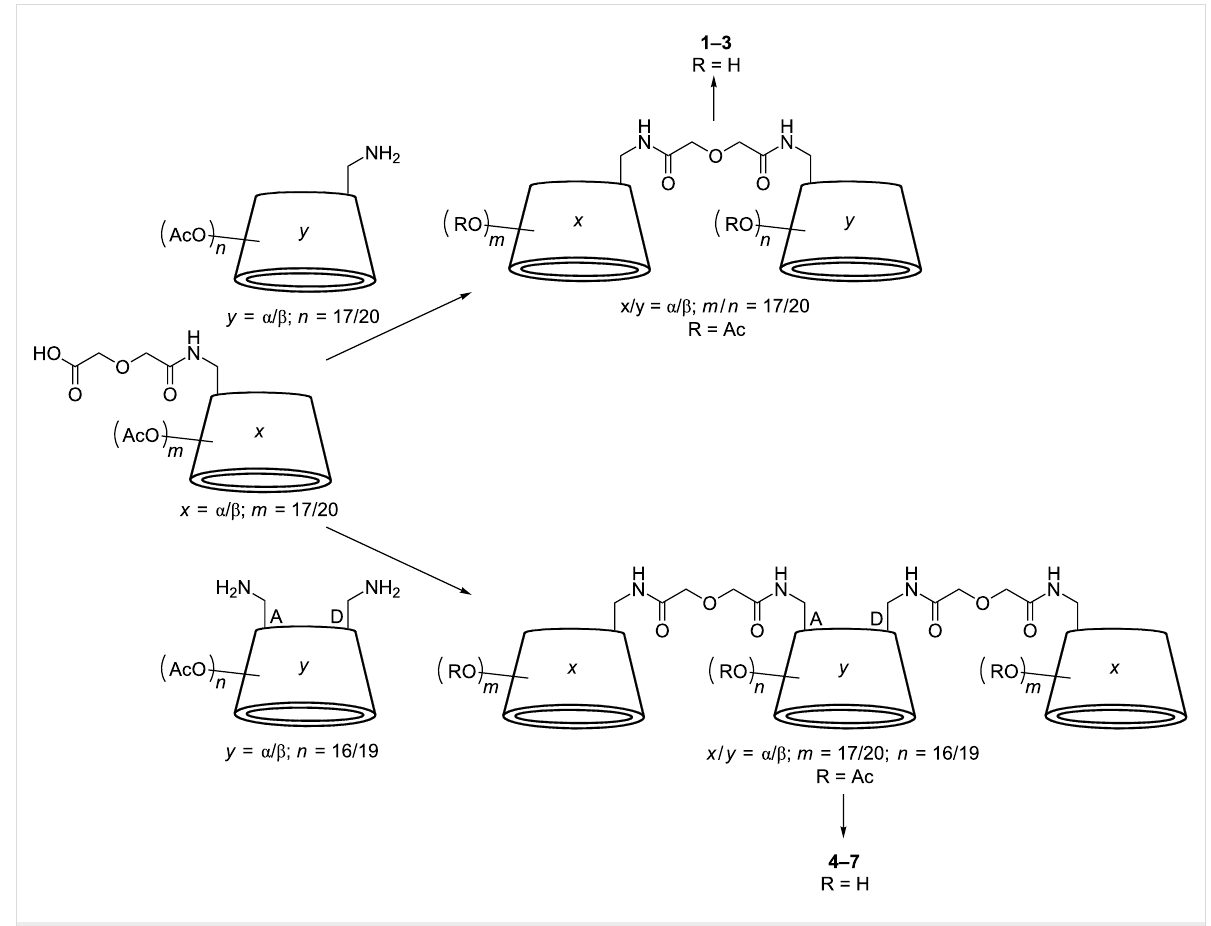
Figure 2: Synthesis of the di- and trivalent CD sequences 1 – 7 (for detailed reaction conditions see Supporting Information File 1).